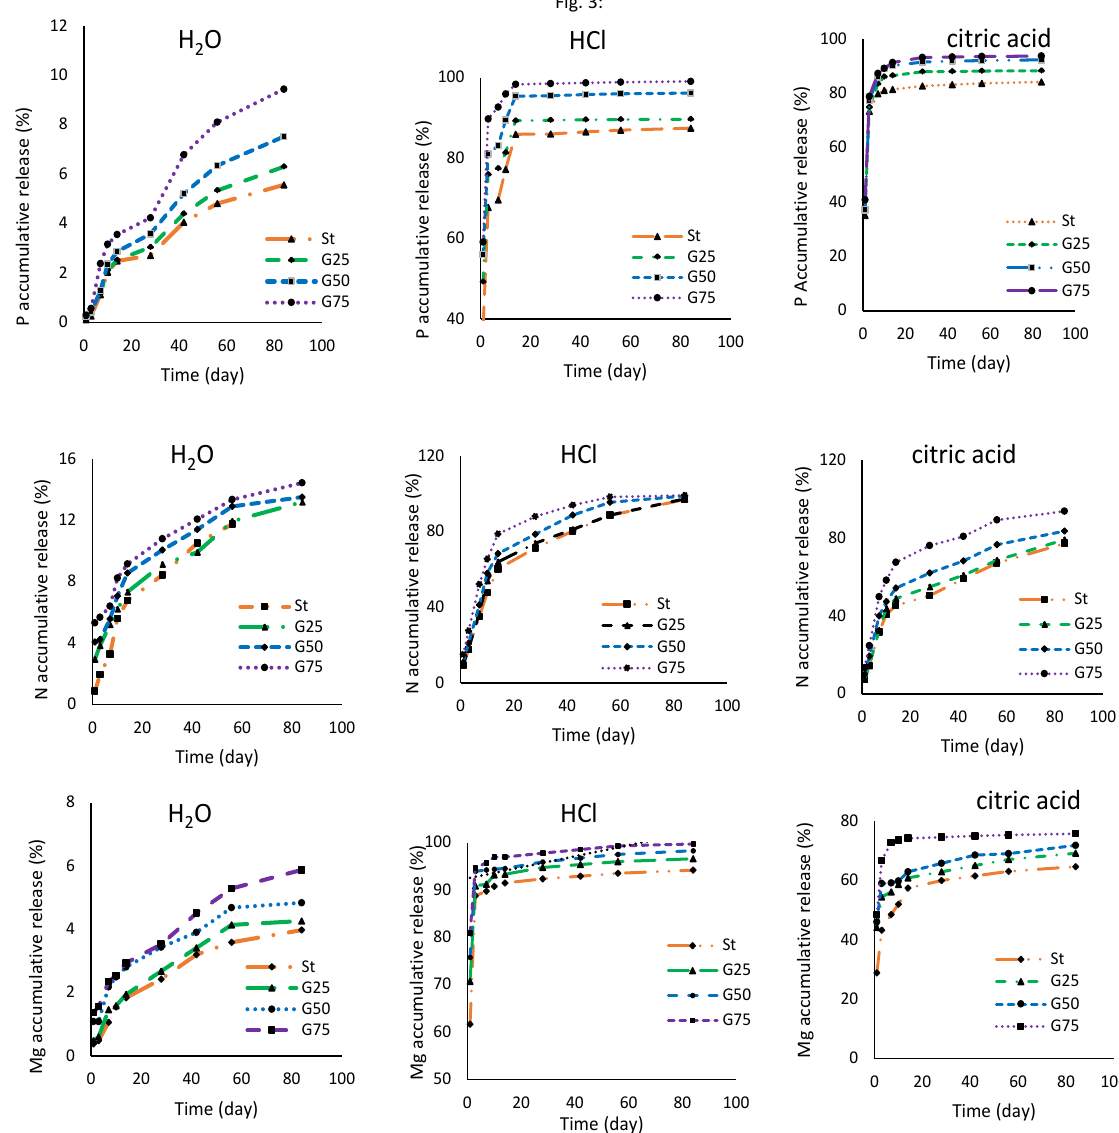
Fig. 3: Cumulative releases of P, N, and Mg from differente %Struvite:%Bbiochar (100:0 (St), 75:25 (G25), 50:50 (G50), 25:75 (G75)) in water, 20 g/L citric acid and 0.5 mol/L HCl.